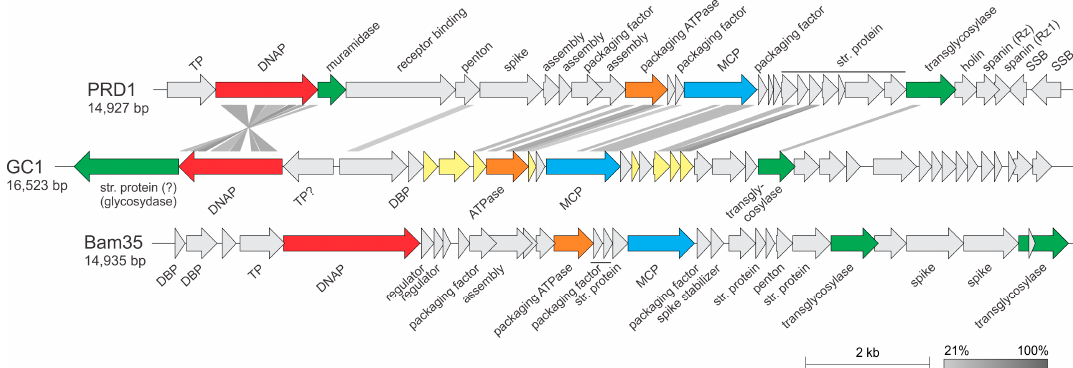
Figure 5. Genome maps of tectiviruses GC1, PRD1 and Bam35. The figure was generated using EasyFig [44] and shows the similarity between translated nucleotide sequences as determined by the tblastx algorithm. Abbreviations: TP, terminal protein; DNAP, family B DNA polymerase; MCP, major capsid protein; str. Protein, structural protein; SSB, single-stranded DNA-binding protein; DBP, DNA-binding protein. ORFs shared with alphatectiviruses are highlighted in light yellow (see Table S1 for annotations). ORFs filled in grey do not have homologs in either of the other two genomes. The color code for gene function is DNAP (red), muramidase (green), packaging ATPase (orange), MCP (blue), transglycosylase (green).